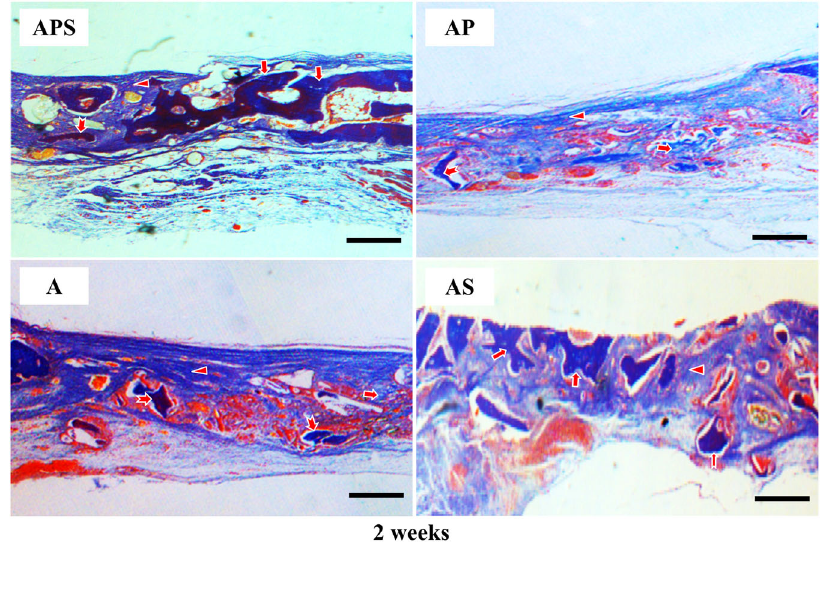
Fig. 3 Histological analysis of defects at 4 weeks (Masson ’